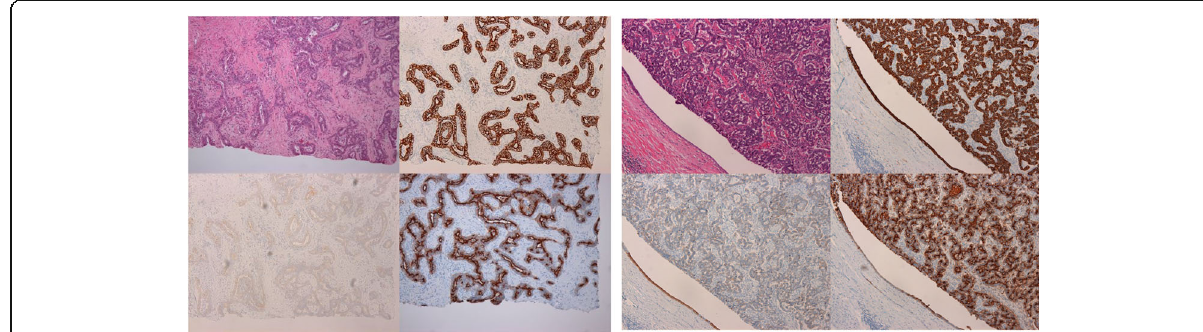
Fig. 4 The histopathological findings of the primary and recurrent tumors (upper left). Immunohistochemistry of both tumors showed the positive expression of cytokeratin (CK) 7, CK19, and EMA (lower left, upper right and lower